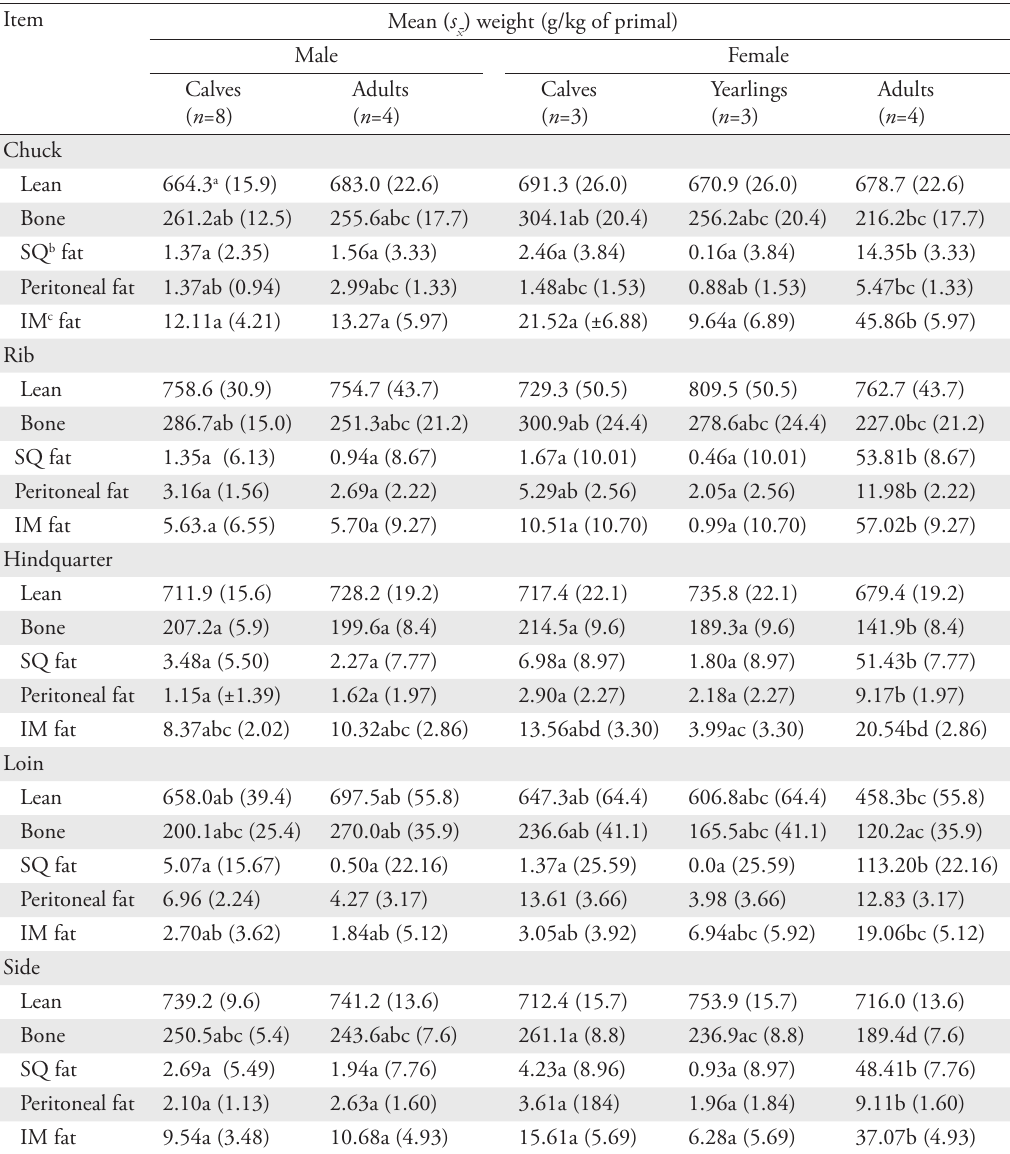
Table 2. Mean (standard error of the mean s ) lean, bone, and fat (subcutaneous, intermuscular, and peritoneal) tis- x - sues (g/kg of primal) of male and female reindeer calves, yearlings, and adults slaughtered in January, 1993 on Nunivak Island,